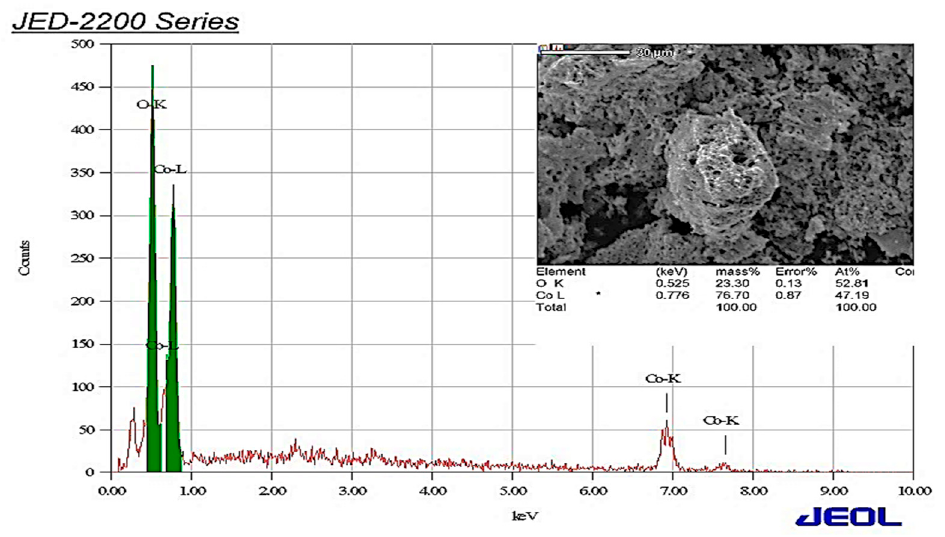
Figure 2. EDX pattern of the as-prepared CoO/Co 3 O 4 NPs.